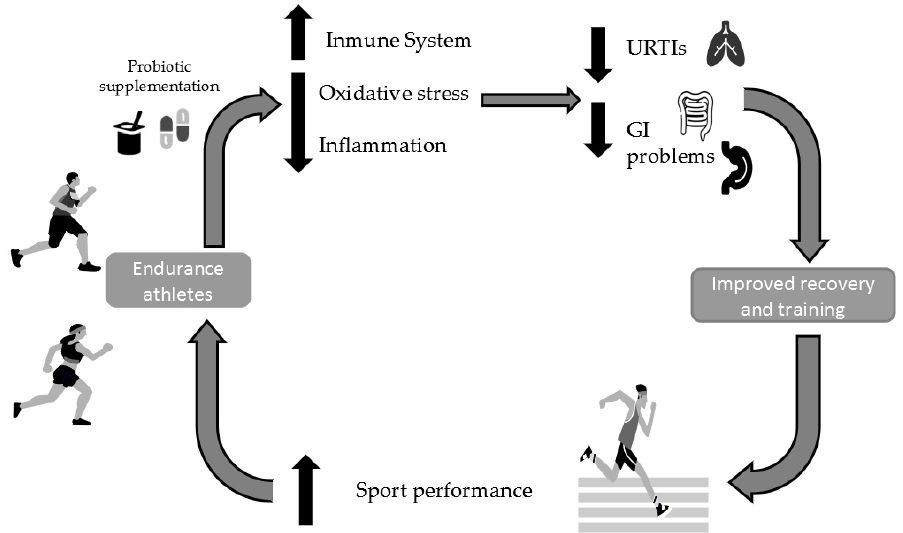
Figure 2. Mechanisms and outcomes of probiotic supplementation in endurance athletes. URTIs: upper respiratory tract infections; GI: gastrointestinal.